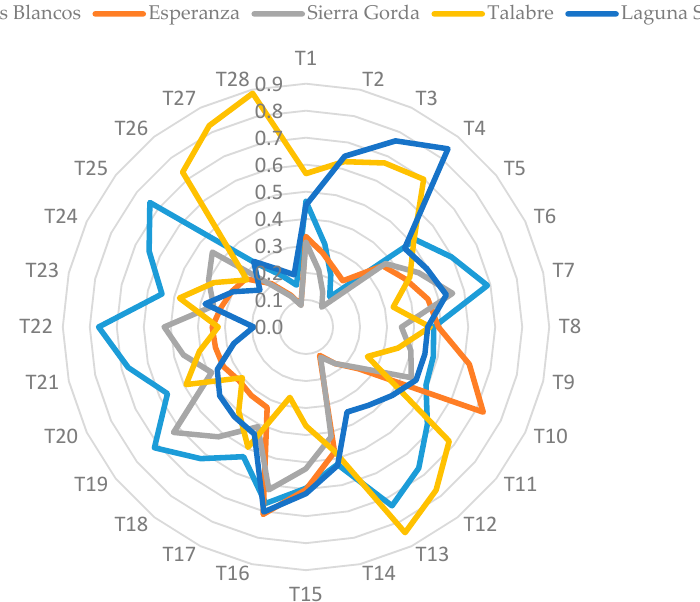
Figure 6. Main results obtained from the technique for order preference by similarity to ideal solution (TOPSIS) method application.